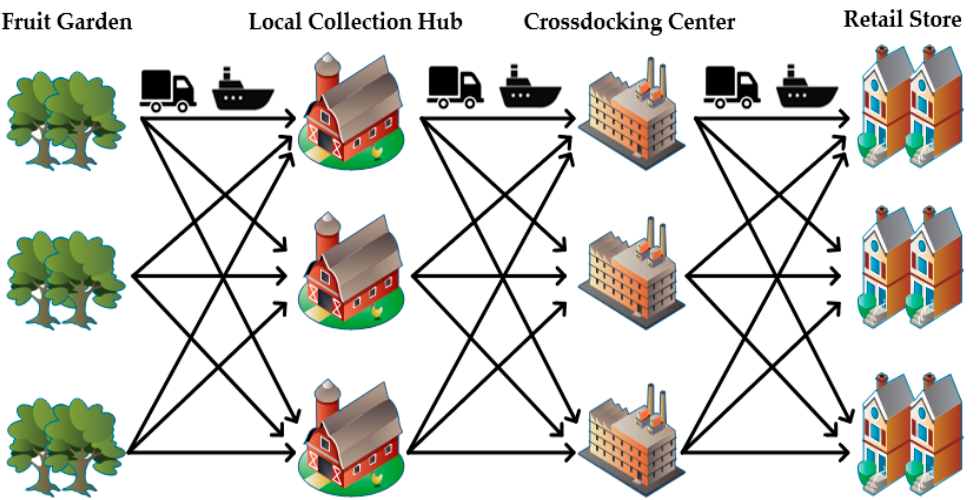
Figure 1. The four-echelon fruit supply chain.